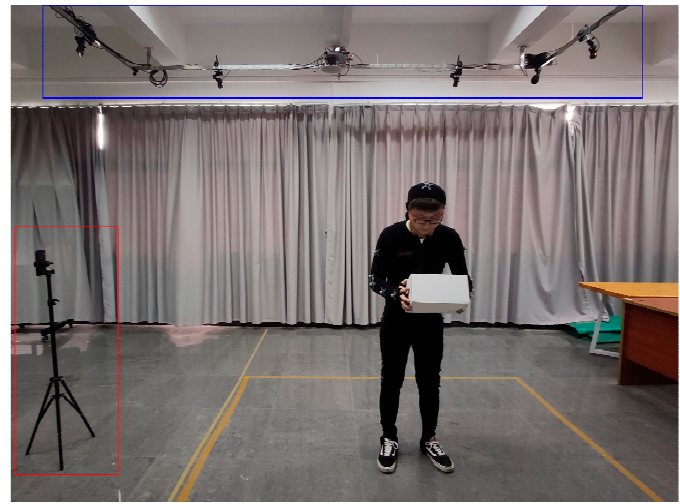
Figure 8. The experimental setting of this study.